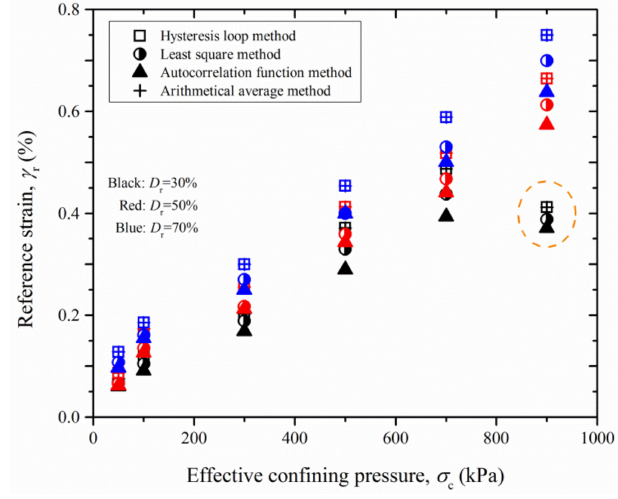
Figure 11. Relationship between γ r and σ c for different determination methods.